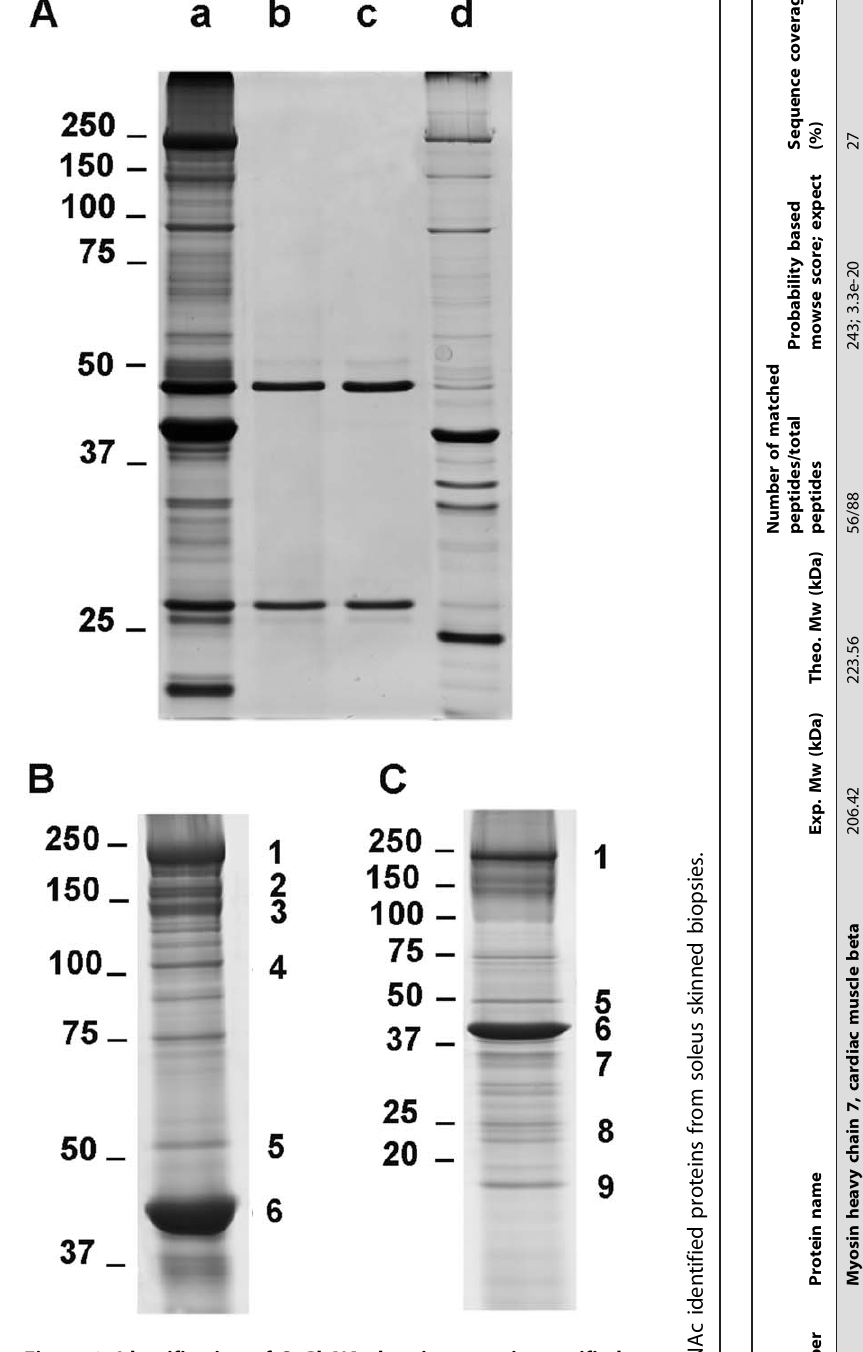
Figure 3. Identification of O-GlcNAc bearing proteins purified from soleus skinned biopsies. (A) corresponds to a silver stained SDS-PAGE of O-GlcNAc proteins purified by RL-2 immunoprecipitation before (a) or after (b) an hexosaminidase treatment; (c) corresponds to immunoprecipitation protocol realized without proteins sample, and (d) to 25 m g of contractile proteins extract. O-GlcNAc proteins were purified by RL-2 immuno-precipitation followed by an electrophoretic separa- tion on 7.5% (B) or 10–20% (C) SDS-PAGE. Gels were colloı¨dal blue stained. Each well-resolved bands were submitted to a mass spectrometry-based identification. Numbers on the two panels indicates the different identified proteins; note that the corresponding identifications are summarized in table